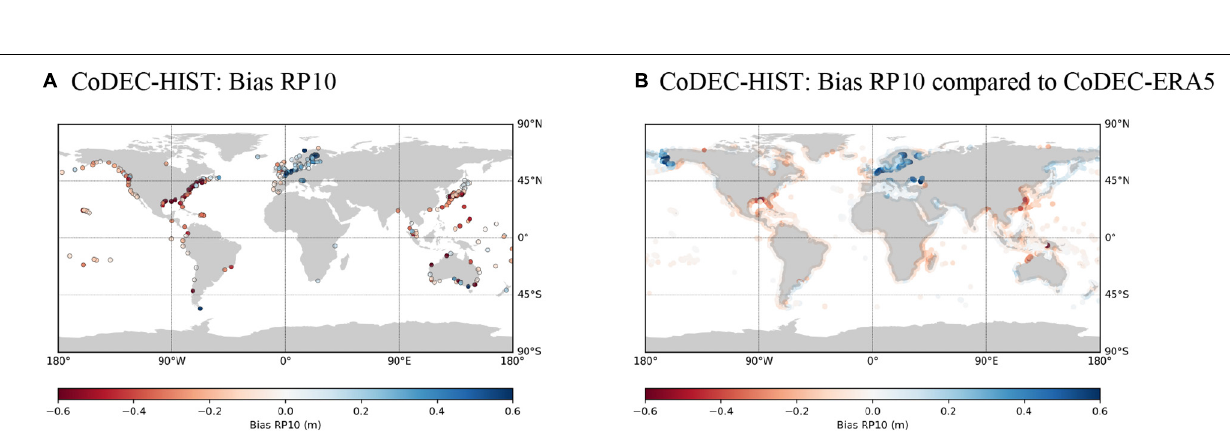
Frontiers in Marine Science |